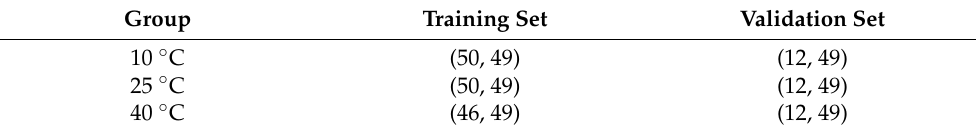
Table 1. Input dataset